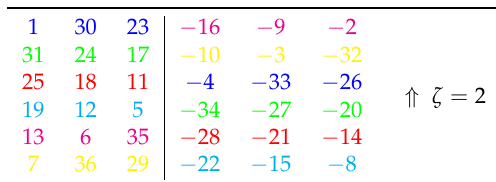
Table 12. Winding Distribution Table for a symmetrical non-reduced winding with N = 36, m = 6, p = 5 and q = 3 / 5 .